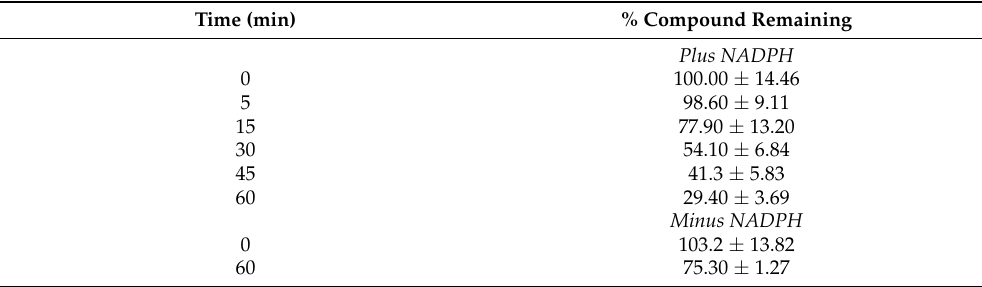
Table 4. Percentage of B06 remaining at each incubation time in HLM.